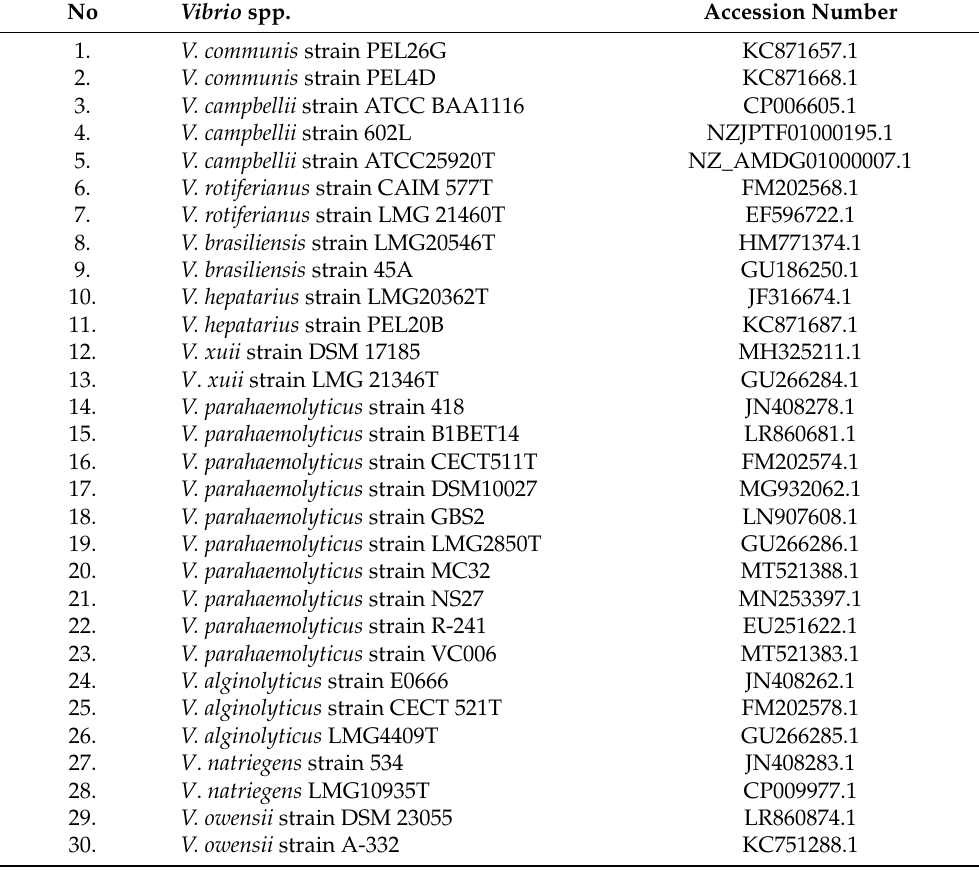
Table A1. List of reference sequences that were included in the phylogenetic